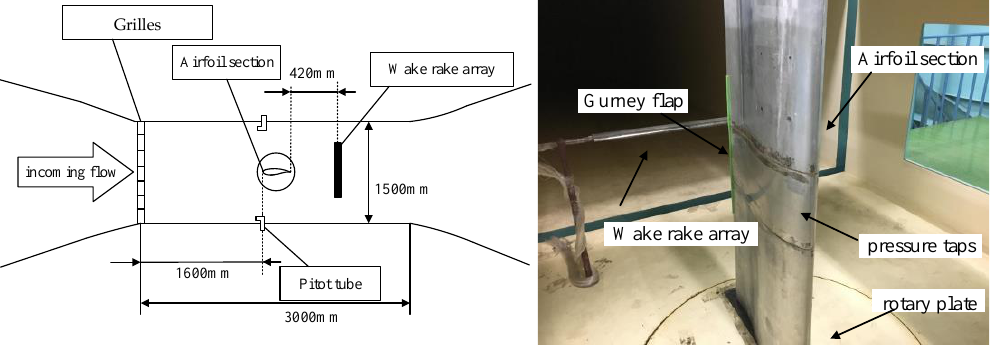
Figure 2. Experimental test device.